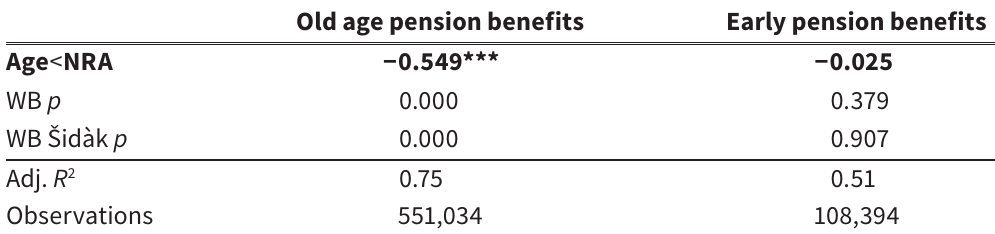
Effect of raising the NRA on Old-age pension and Early pension types (Eq. 2) Old age pension